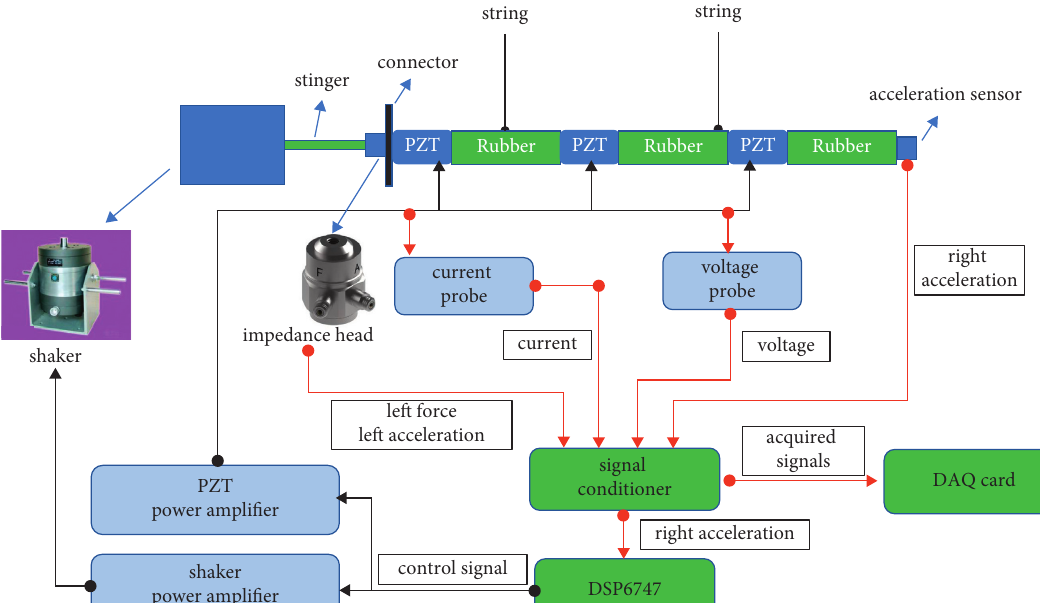
Figure 24: Schematic diagram of the setup.